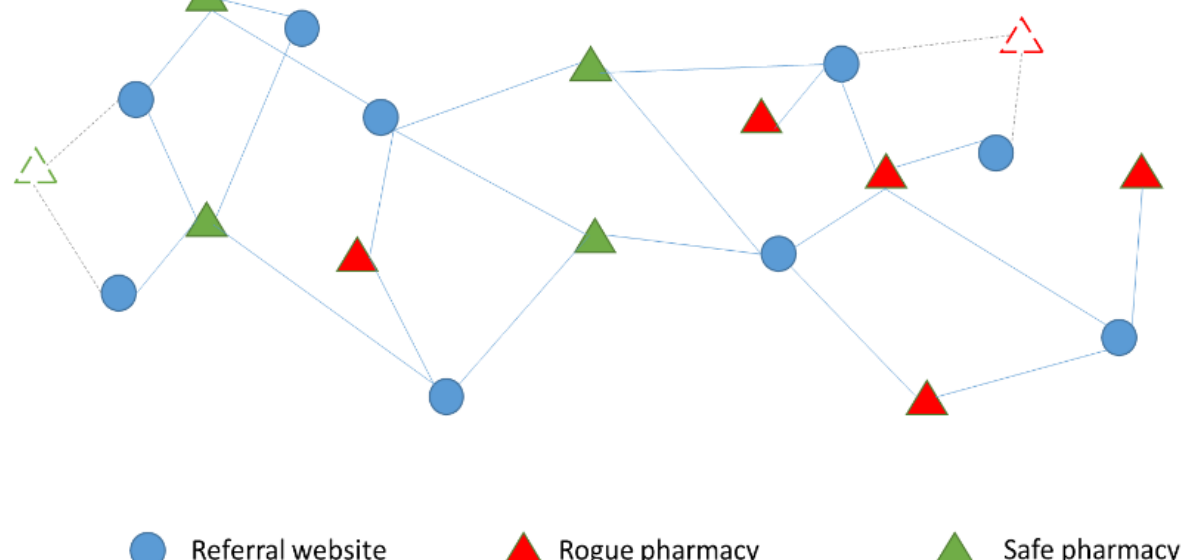
Figure 1. Simple Demonstration of Links Between Referral Websites and online